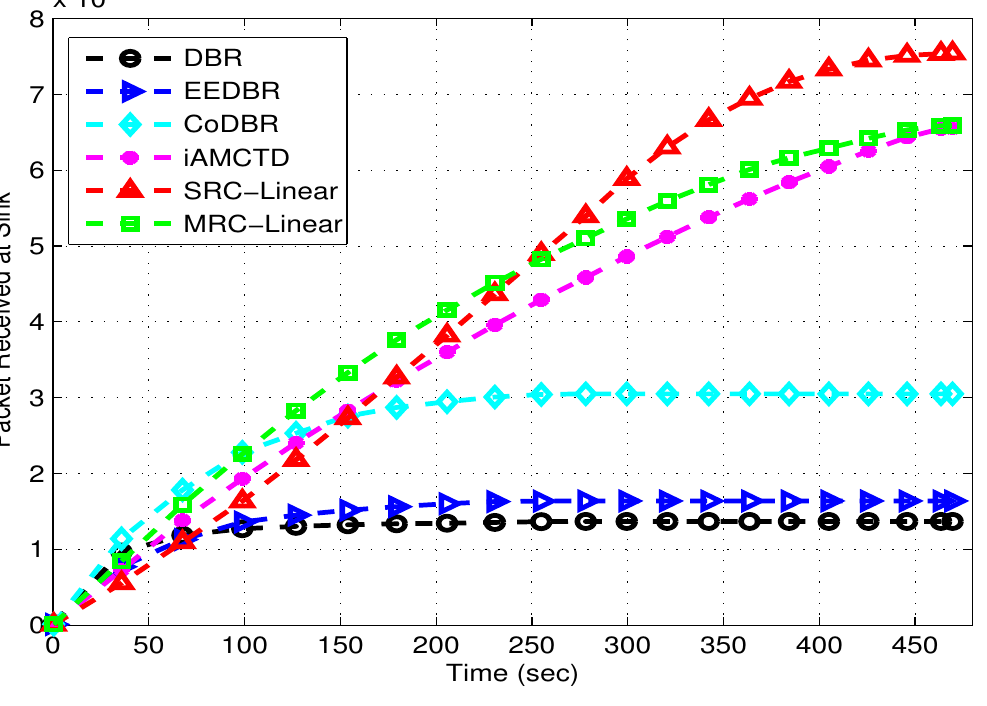
( a ) Linear sink mobility patterns.